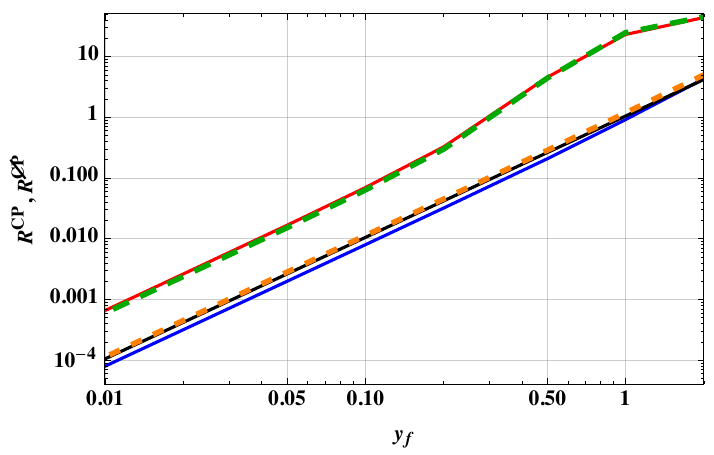
Figure 2 . Ratio of the NLO and LO contributions to the relaxation rate R cp (cid:17) j (cid:0) (cid:0) nlo j = j (cid:0) (cid:0) lo j and (cid:30) cp (cid:30) cp (cid:30) source term R cp (cid:17) j S nlo j = j S lo j , evaluated deep in the broken phase. The blue (red) line shows R cp for quarks (leptons), and the dashed orange and green lines show R cp respectively. The black line shows the estimate of R cp and R cp limit, corresponding to eq. (5.6) and eq. (5.14) with (cid:1) cp ; (cid:1) cp ’ N = 100 GeV and T = 100